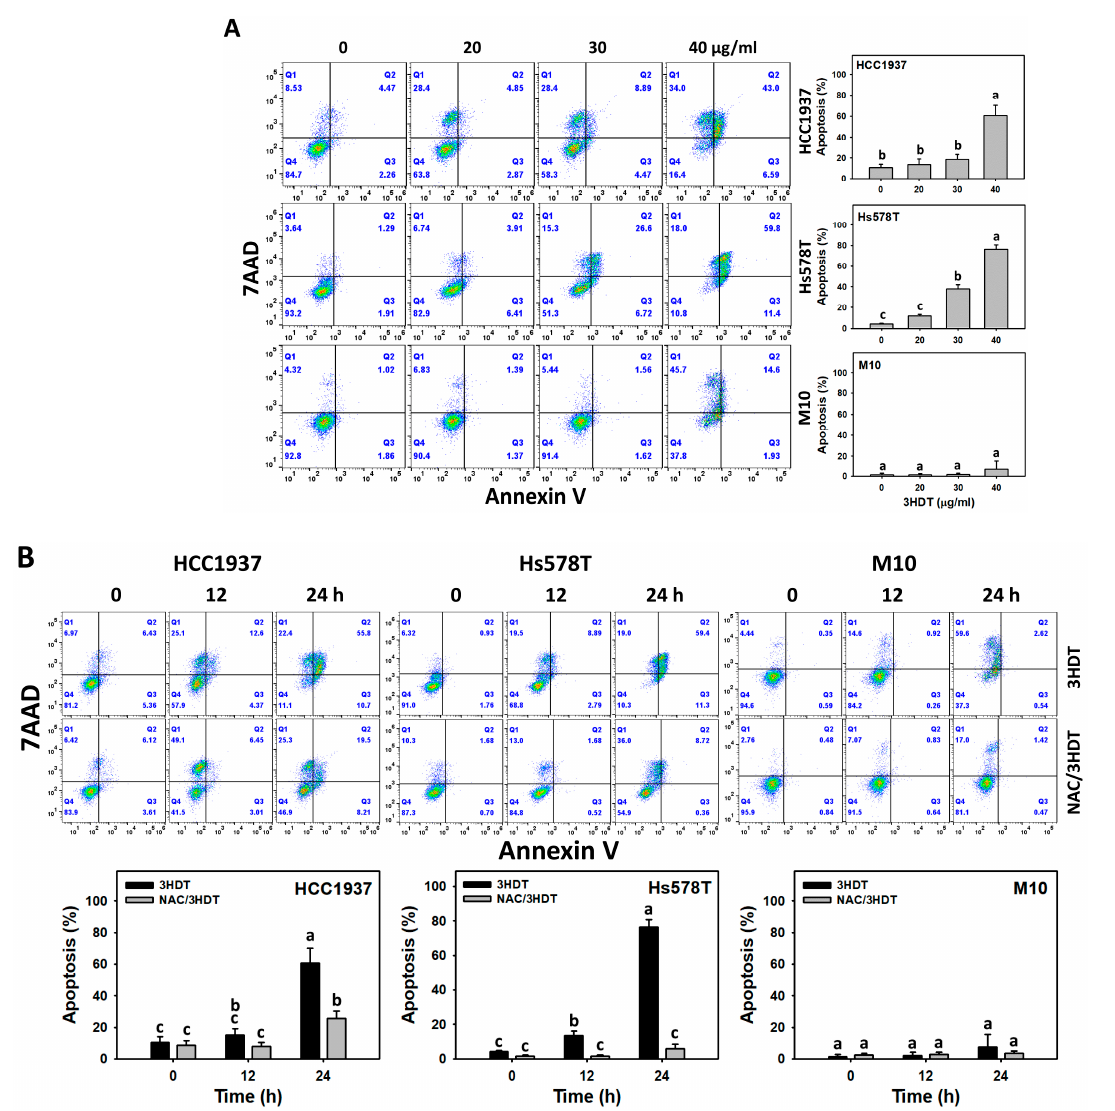
Figure 3. Annexin V status of 3HDT treatment. ( A ) Annexin V flow cytometry assay of 3HDT (control, 20, 30, and 40 μ g/mL) for 24 h. ( B ) Annexin V flow cytometry assay of NAC/3HDT. 3HDT and NAC/3HDT indicate 12 or 24 h 3HDT treatment (40 μ g/mL) without and with NAC pretreatment, respectively. Q1 is classified as necrosis region [23,24]. Q2 and Q3: Annexin V (+)/7AAD (+/ − ) (%) is regarded as apoptosis (%) [23,24]. Data: mean ± SD ( n = 3). Treatments differ significantly for multiple comparisons when the letters are not overlapping ( p < 0.05).